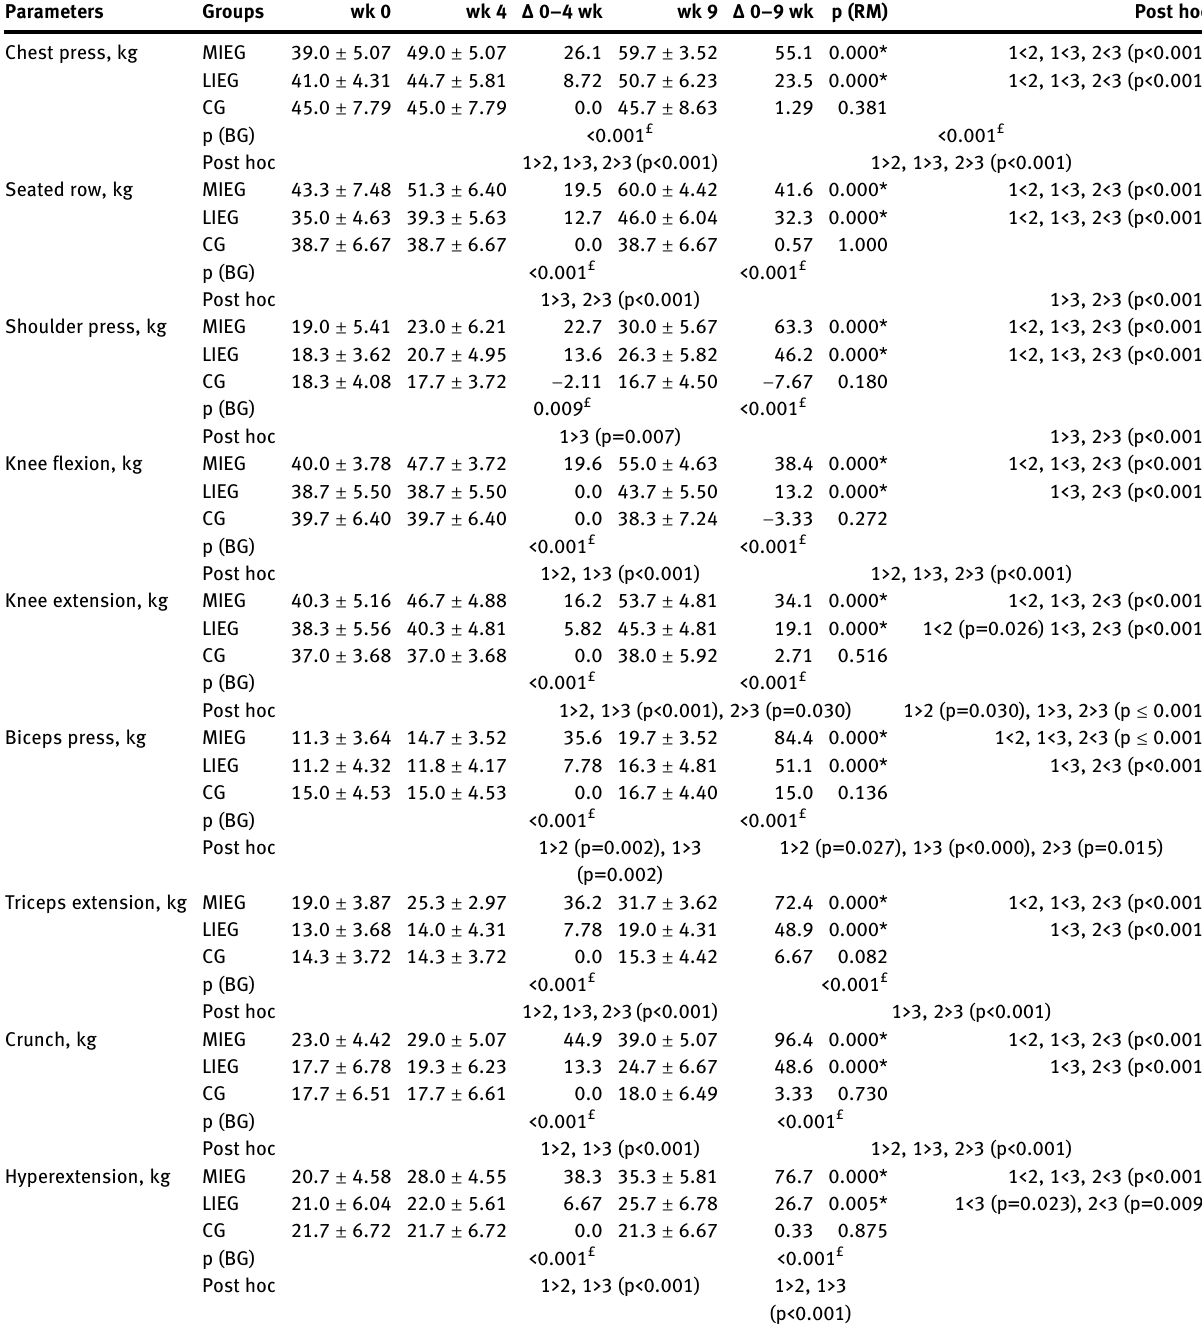
Table  : Chance of strength output after eight wk of resistance training with different intensities. Parameters